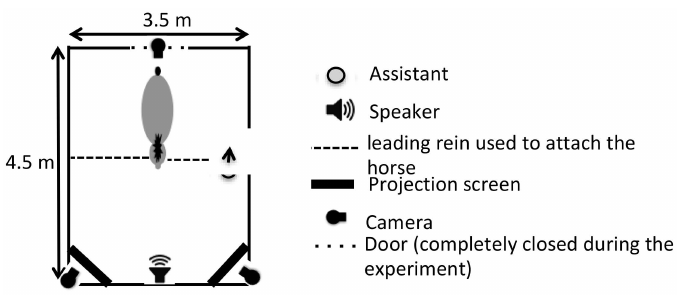
Figure 1. Schematic representation of the experimental